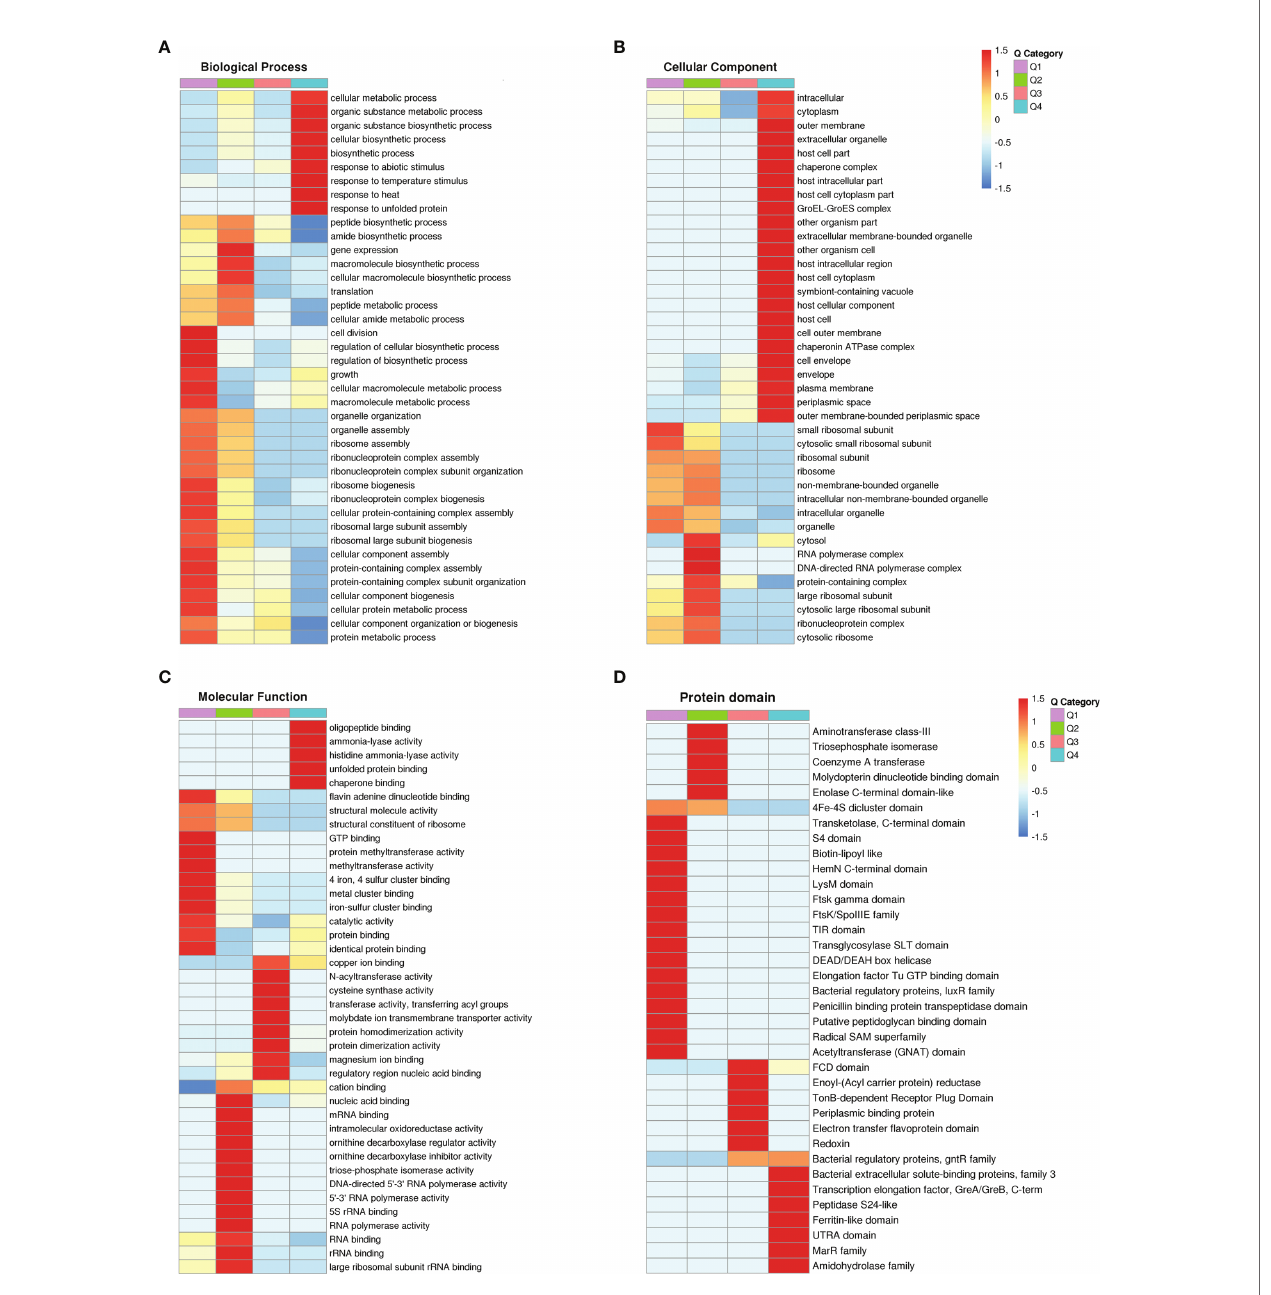
FIGURE 4 | Functional cluster analysis of GO and protein domain of DEPs. (A – C) GO functional clustering analysis. (D) Protein domain functional clustering